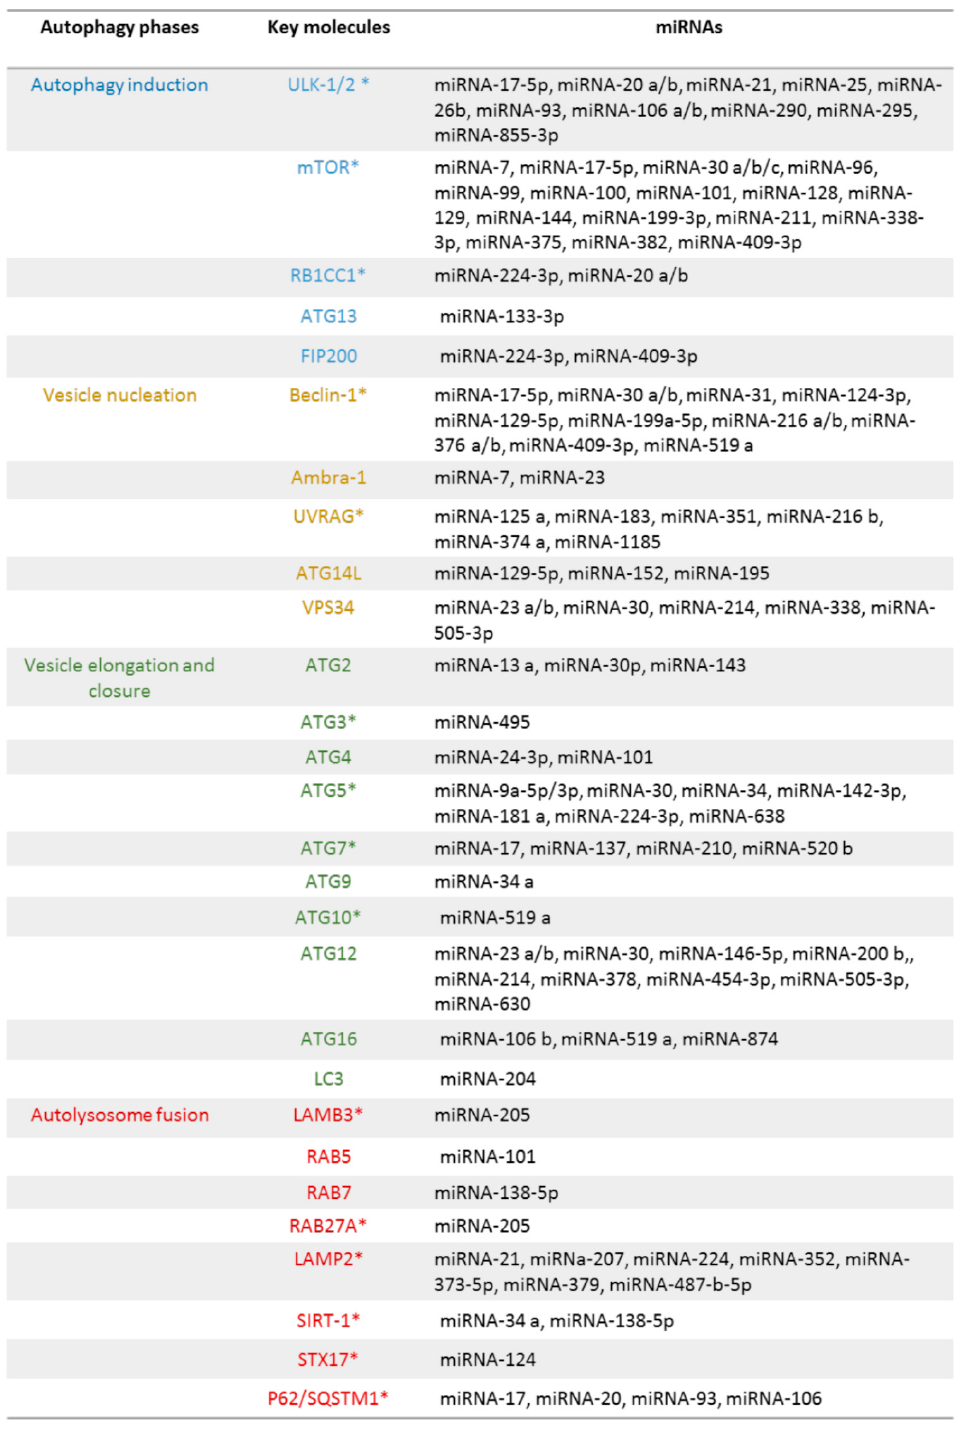
Figure 6. Regulation of autophagy by miRNA. Genes marked with * are TFEB target genes